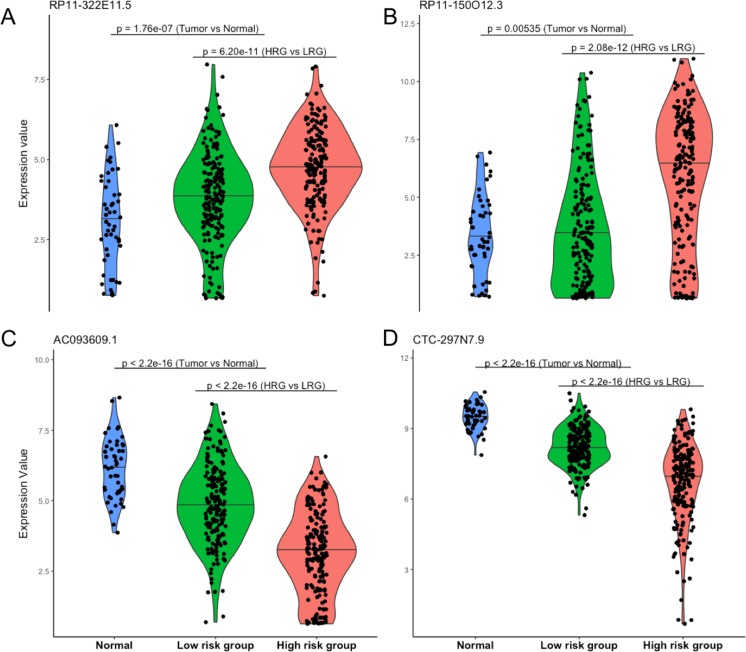
Expression patterns of four prognostic lncRNAs.(A) Expression pattern of RP11-322E11.5. (B) Expression pattern of RP11-150O12.3. (C) Expression pattern of AC093609.1. (D) Expression pattern of CTC-297N7.9. Normal indicates paired adjacent tissue from a subset of 371 primary tumors; Low/High risk subgroups were divided by our risk score model; statistical significance between different subgroups were performed with the two-tailed Wilcoxon test.